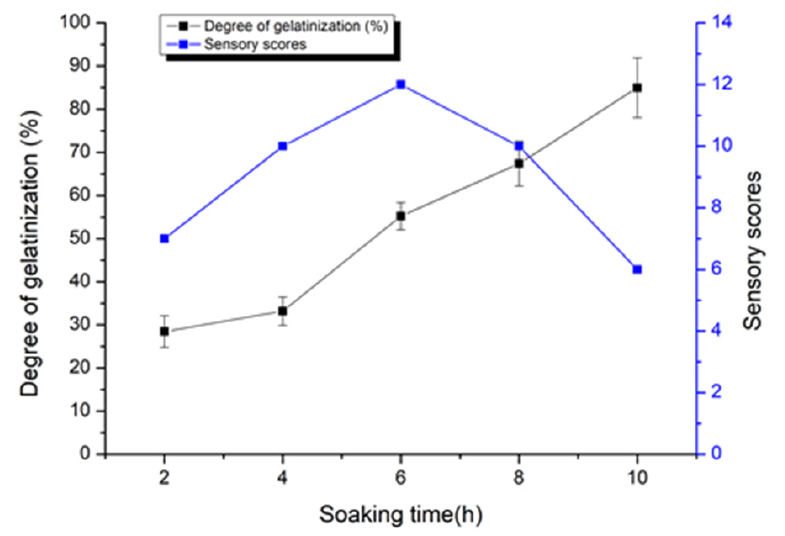
Figure 1. Typical changes in the degree of gelatinization and sensory scores of the soaking time. It can be seen from Figure 2 that as the microwave power was increased, the gelatiniza- tion degree of adzuki beans gradually increased. When the microwave power is small, the thermal effect and the vibration effect was not strong that resulting in a small degree of gelatinization of the adzuki beans starch. With the increase of microwave power, melting occurred in the crystallization zone and the hydrogen bond between starch molecules was broken, hydrophilic groups were exposed that improved the degree of gelatinization. The previous study proved that the higher the power, the more serious the damage, resulting in a greater degree of gelatinization [23,24]. The sensory score increased first and then decreased with the extension of microwave power. When the microwave power is 1000 W, the degree of gelatinization is the highest (69.75%), It also has a great influence on the color and appearance when the microwave power is too high. Therefore, suitable results were found with 800 W microwave